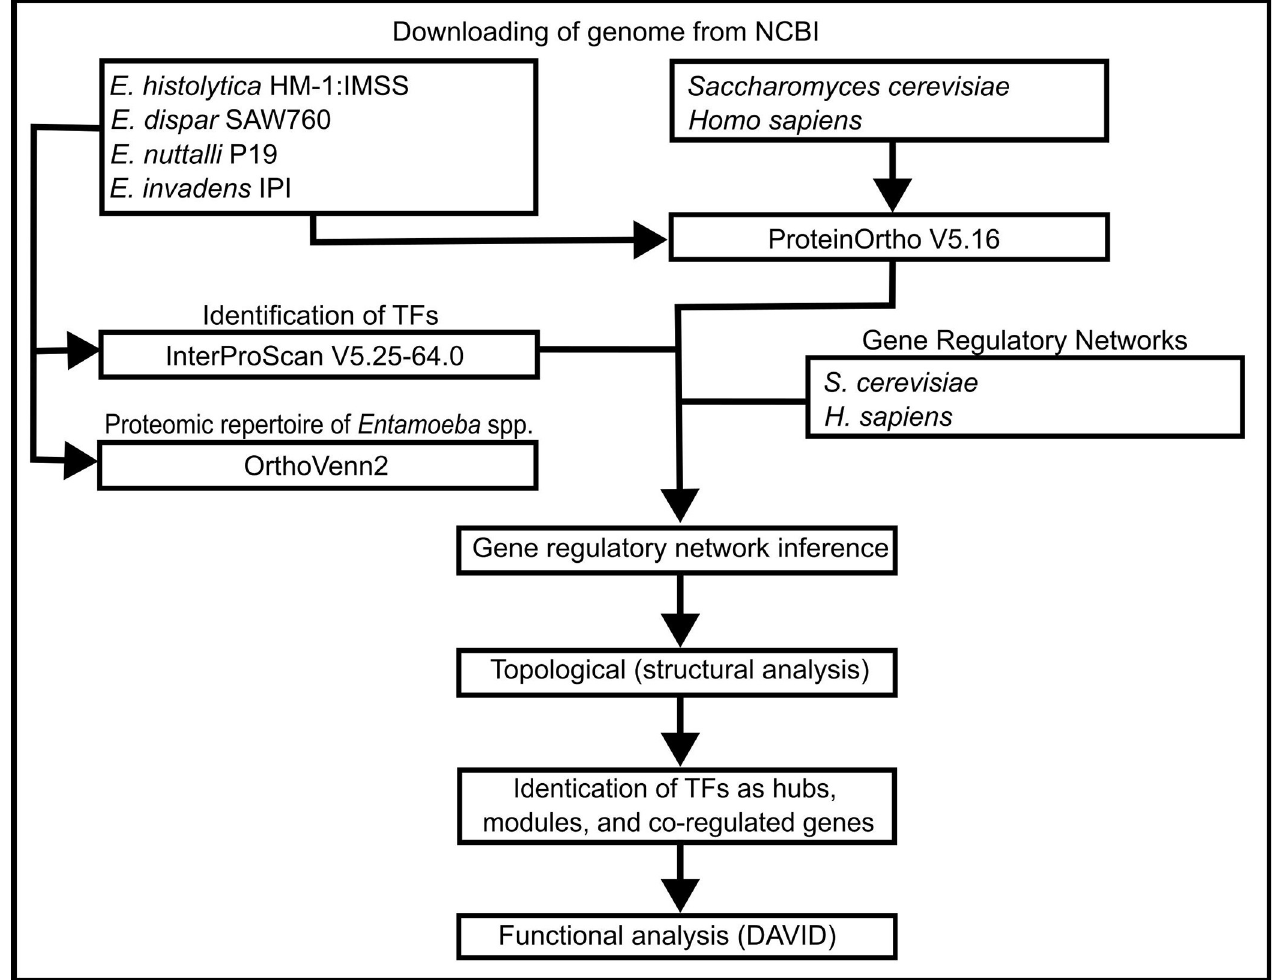
Fig 1. Schematic workflow of the network inference procedure steps. Four Entamoeba genomes were downloaded from NCBI and compared with Orthovenn, to infer the common set of orthologous proteins. Interproscan was used to assign protein domains (Pfam and Supfam). To infer the GRN, two organismal models were used, S.cerevisiae and H. sapiens, and the ProteinOrtho was considered. The GRNs inferred were evaluated in terms of their topological properties, hubs, and functional